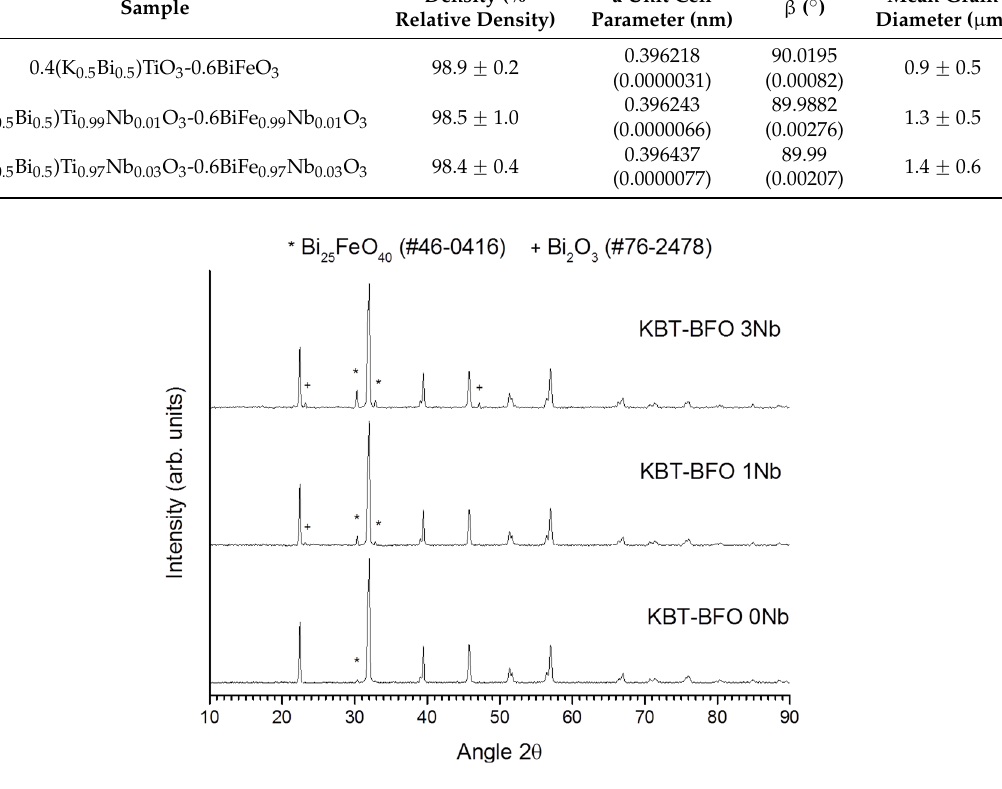
Figure 1. X ‐ ray diffraction (XRD) traces of 0.4(K 0.5 Bi 0.5 )Ti (1 − x ) Nb x O 3 ‐ 0.6BiFe (1 − x ) Nb x O 3 powders after calcination at 900 °C for 5 h.